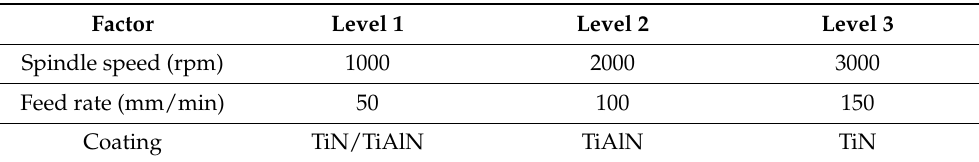
Table 4. Details of cutting parameters and tool coatings used in the